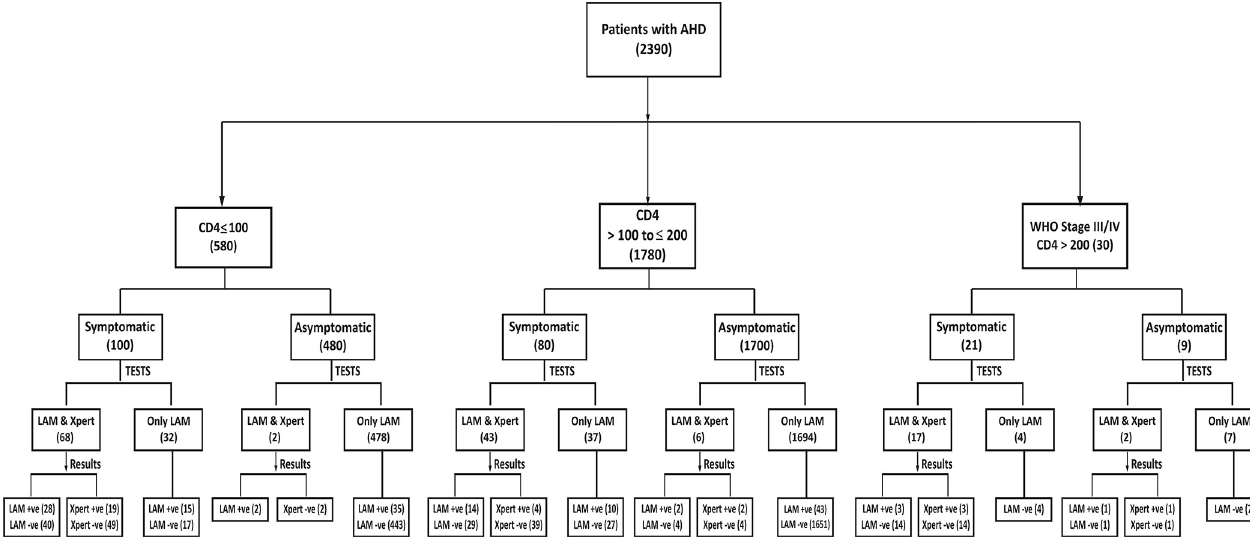
Fig 2. Flow diagram depicting the positivity of urine LF-LAM and sputum Xpert among 2,390 patients by CD4 count, WHO staging, and TB symptoms.